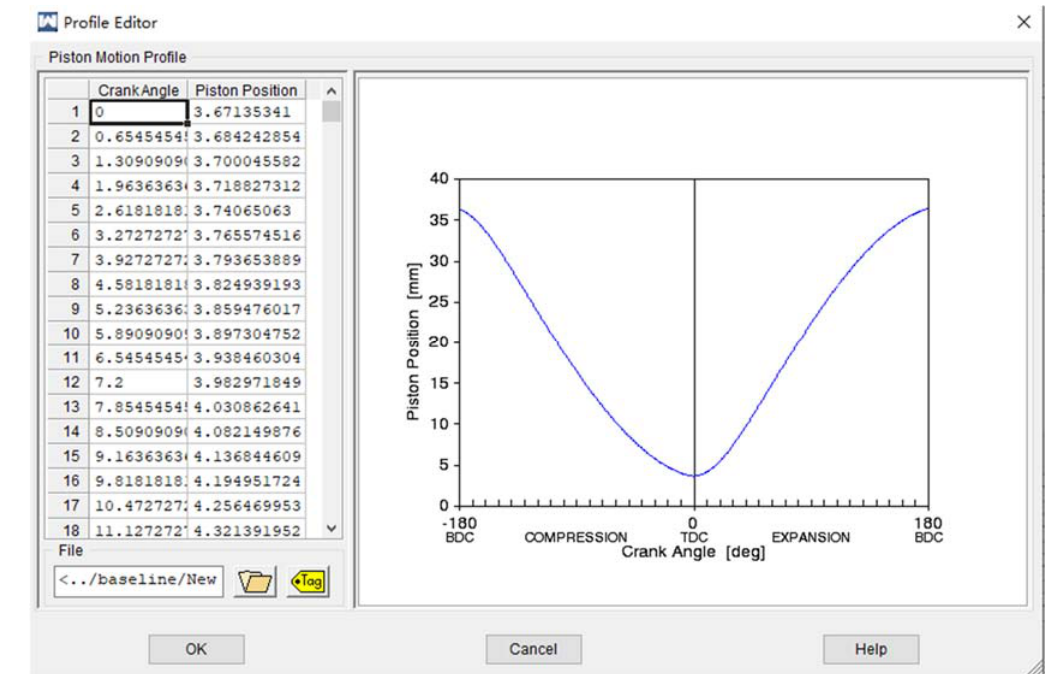
Figure 7. Profile editor for piston motion profile to model free-piston engine.